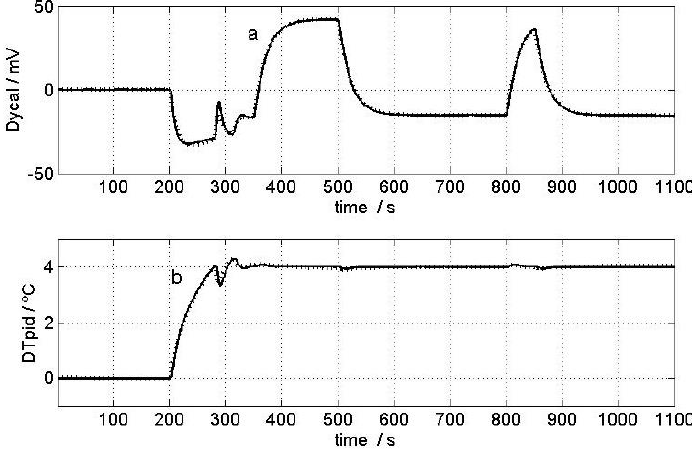
Figure 7. Calibration. Fit between the experimental curves (lines) and those calculated using the model (points): ( a ) Calorimetric signal; and ( b ) thermostat temperature. Curves feature a corrected baseline.